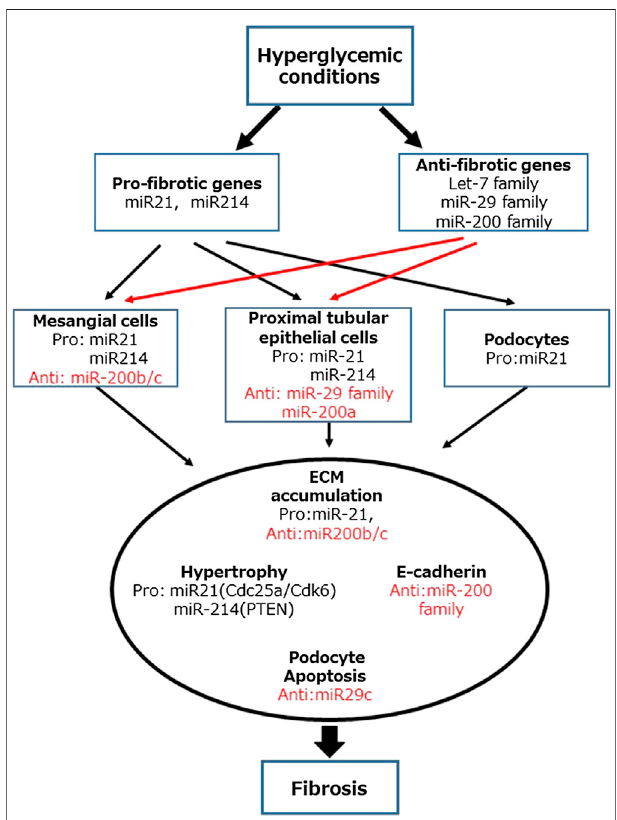
TABLE 1 | Validated mature miRNAs relevant to DKD Anti fi